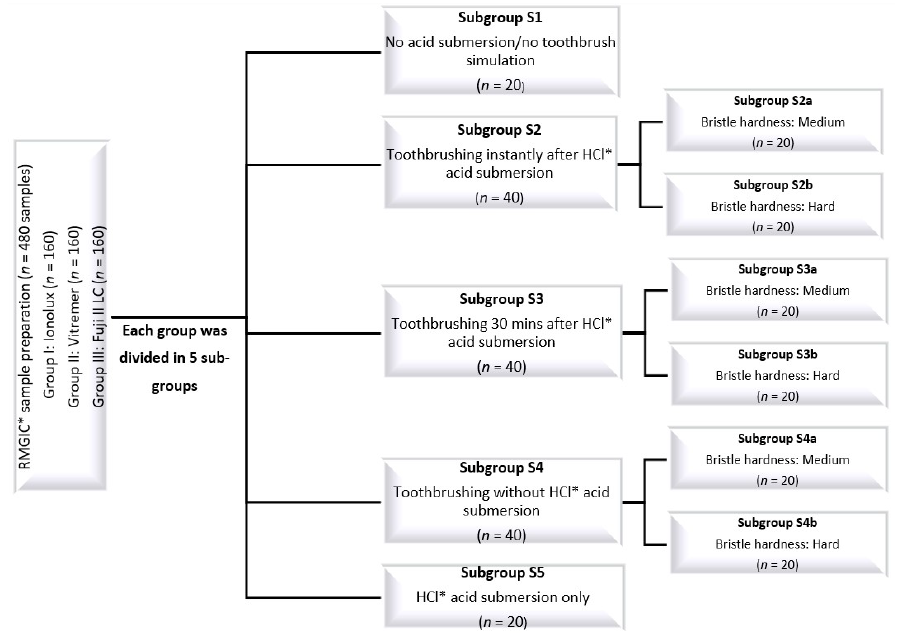
Figure 1. The design of the study. * RMGIC—Resin-modified glass-ionomer cement; HCl—Hydrochloric acid.